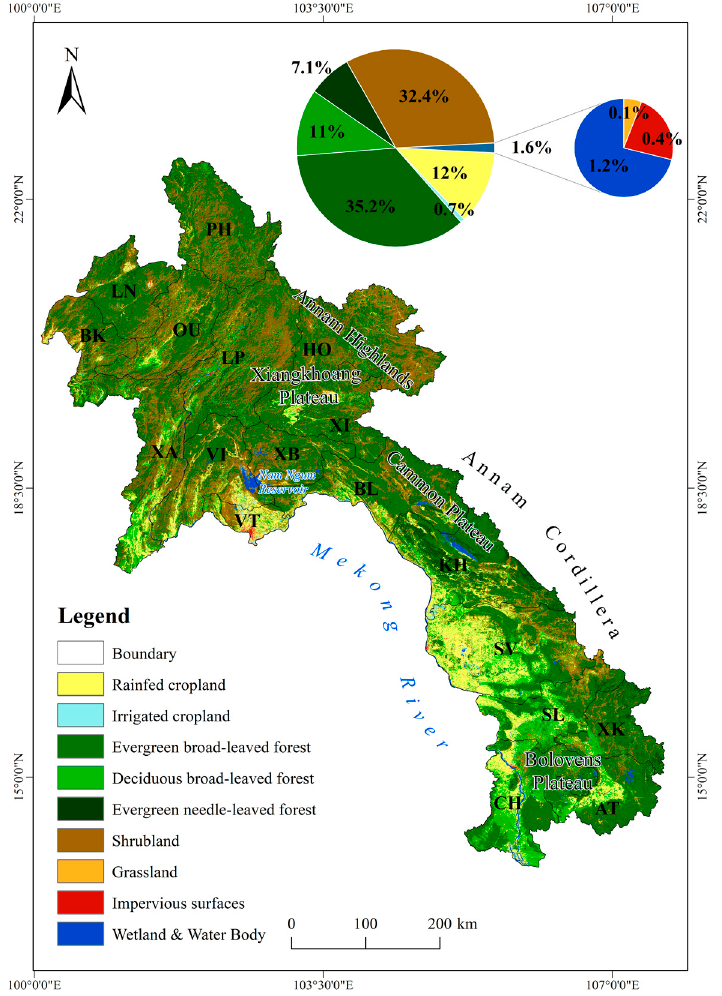
Figure 2. LUC map of Laos in 2020.